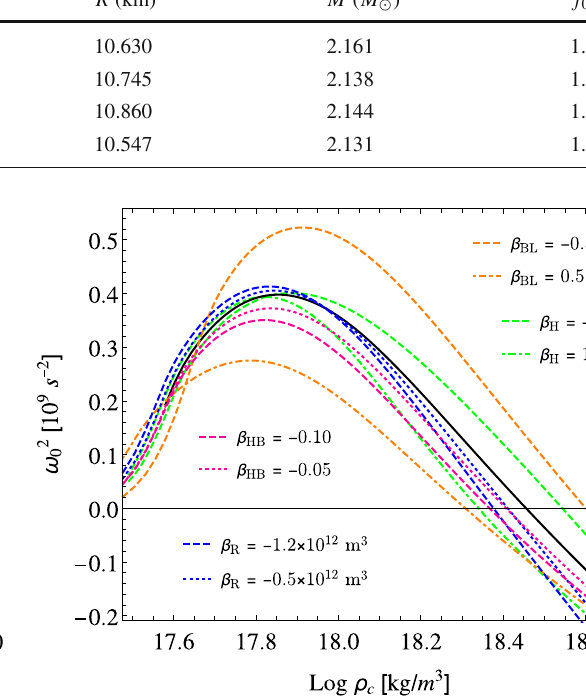
Table 2 Anisotropic neutron